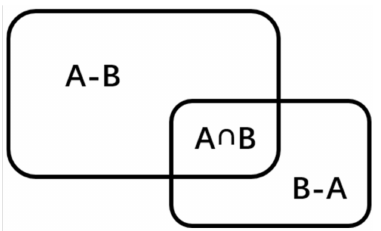
Figure 5. Graphical illustration of relationships between two features.